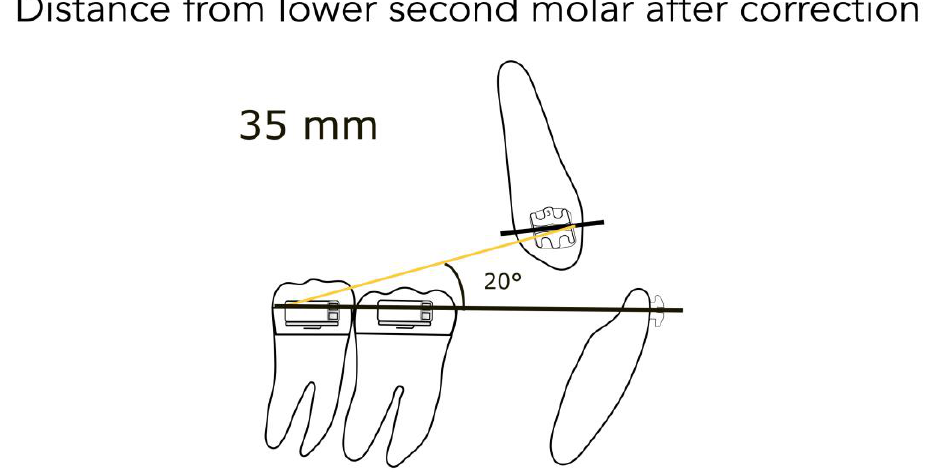
Figure 5. Distance from the lower second molar after